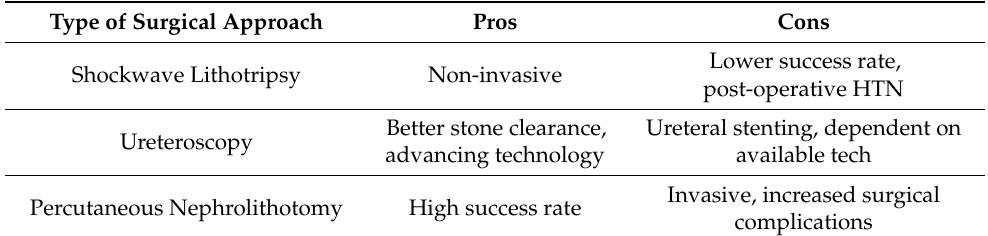
Table 5. Pros and cons of main surgical approaches in pediatric